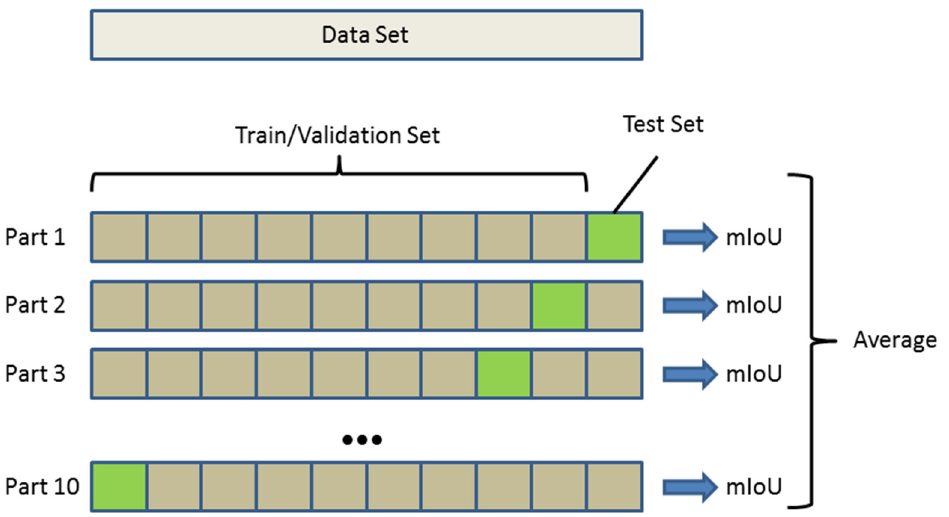
Figure 5. Comparison of segmentation results. ( a , e ) The original image. ( b , f ) GT image. ( c , g ) Unweighted. ( d , h ) Seg- mentation with λ -MAE-0.1.